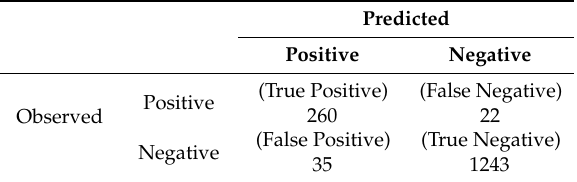
Table 11. Results of algorithm performance evaluation at event level: raw data.